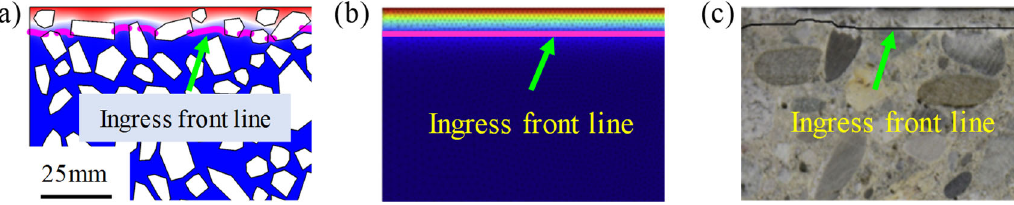
Figure 10. Ingress front lines of sulfate ion concentration from ( a ) present numerical simulation, ( b ) numerical simulation in literature [36], and ( c ) experiments in literature [36], respectively.